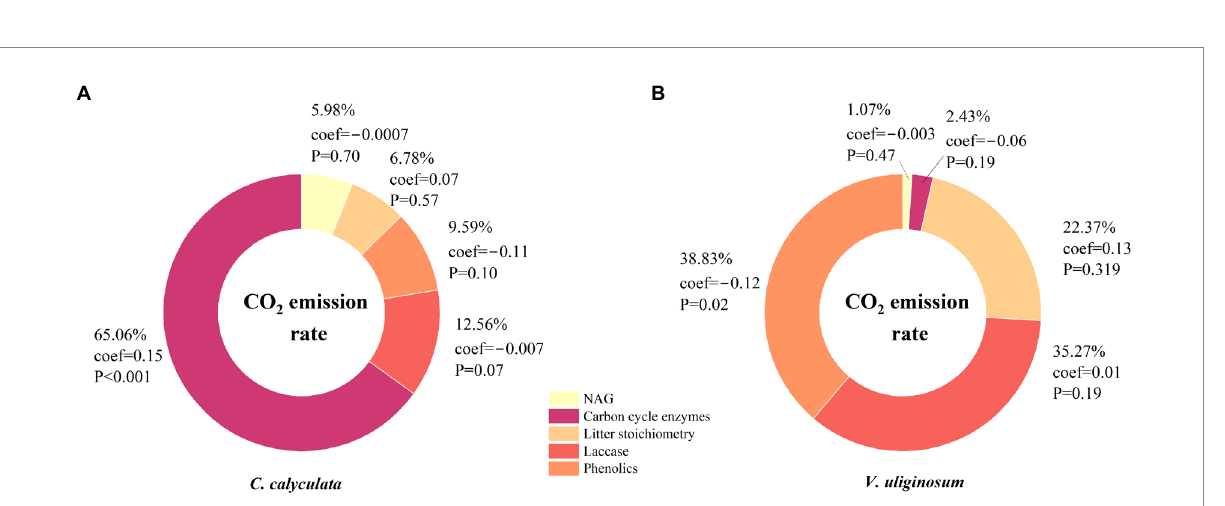
FIGURE 4 The relative weights of the effects of the soil enzyme activity and litter chemistry on the rate of CO 2 emissions from the C. calyculata (A) and V. uliginosum (B) litter under the different treatments. A principal component analysis (PCA) was used, resulting in five explanatory variables: the litter stoichiometry, soil carbon cycle enzymes, soil nitrogen cycle enzymes, laccase, and phenolics. The percentages show the relative weight of these variables, and coef refers to the standardized regression coefficient. The p -values represent the effects of the explanatory variables on the CO 2 emission rates.